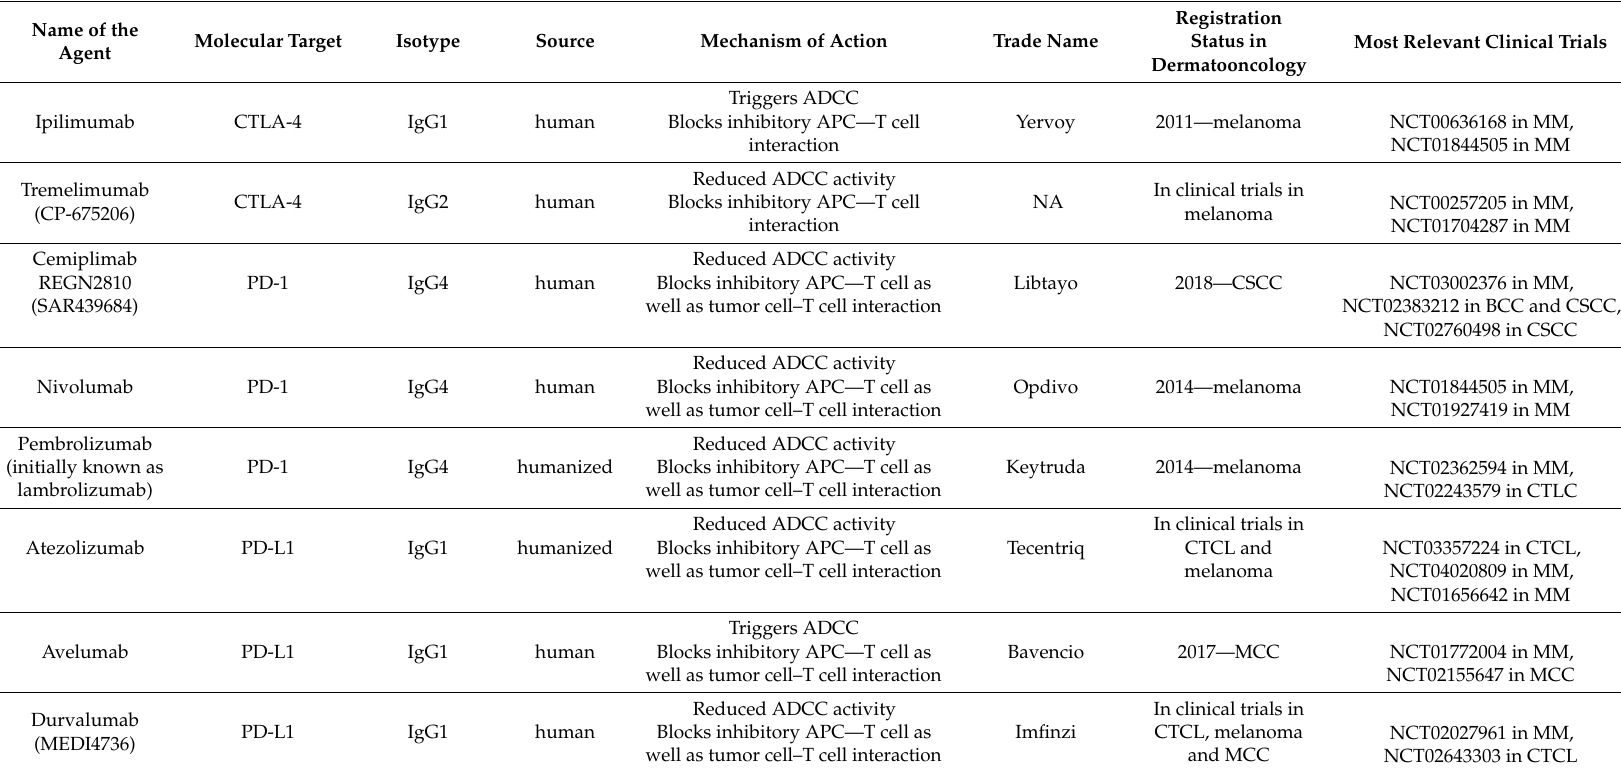
Table 1. Monoclonal antibodies (mAbs) targeting Cytotoxic T-Lymphocyte-Associated protein 4 (CTLA-4) and Programmed Cell Death-1 (PD-1) / PD-1 ligand-1 (PD-L1) currently in use in